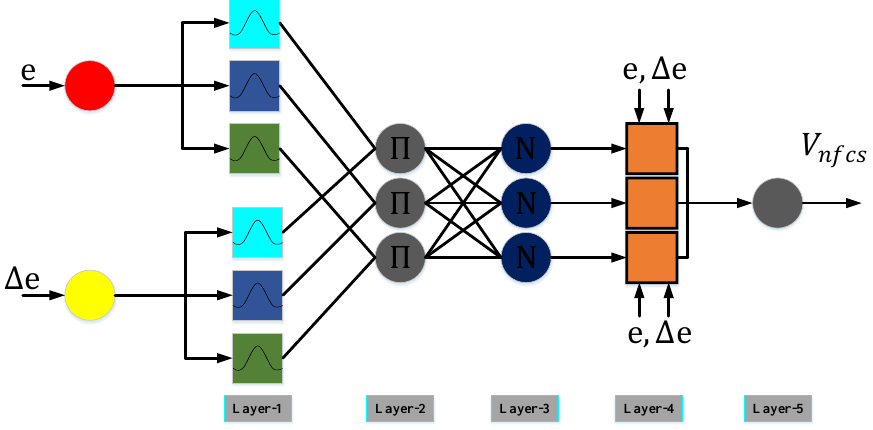
Figure 19. Sugeno type two input NFC structure [44].